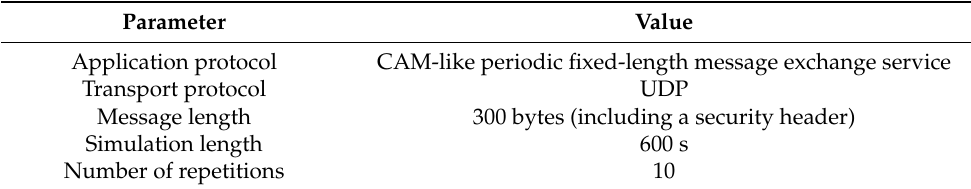
Table 2. Simulation parameters.